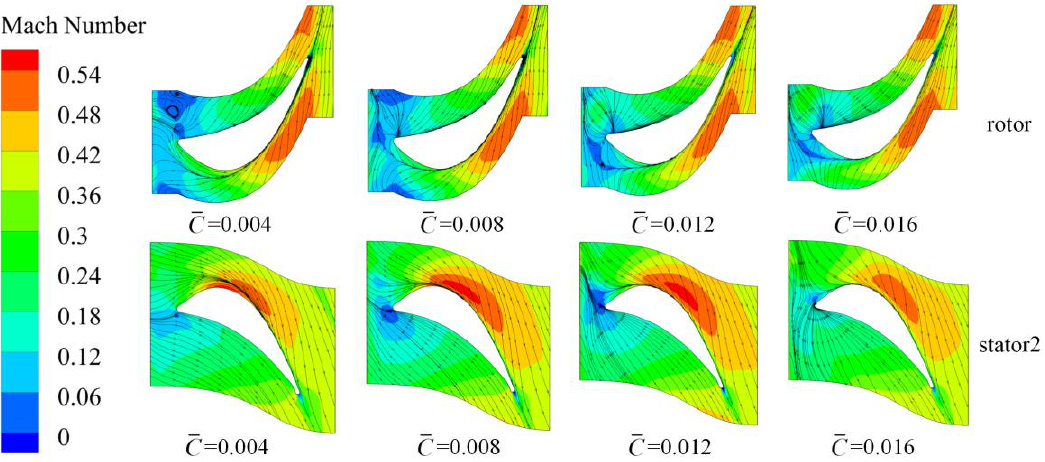
Figure 7. The Mach number contours: (up: 1% blade height of rotor; down: 99% blade height of stator2).